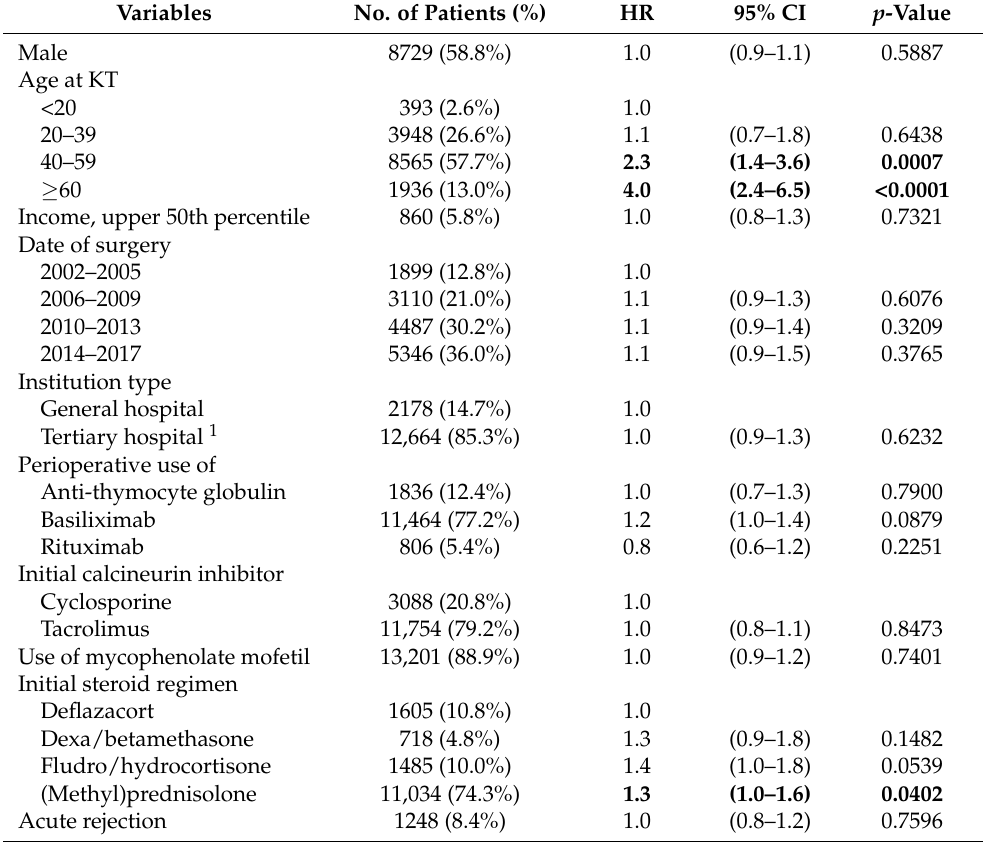
Table 4. Risk factors and multivariate hazard ratios by the Cox proportional hazards model for occurrence of any de novo primary cancer in 14,842 patients after kidney